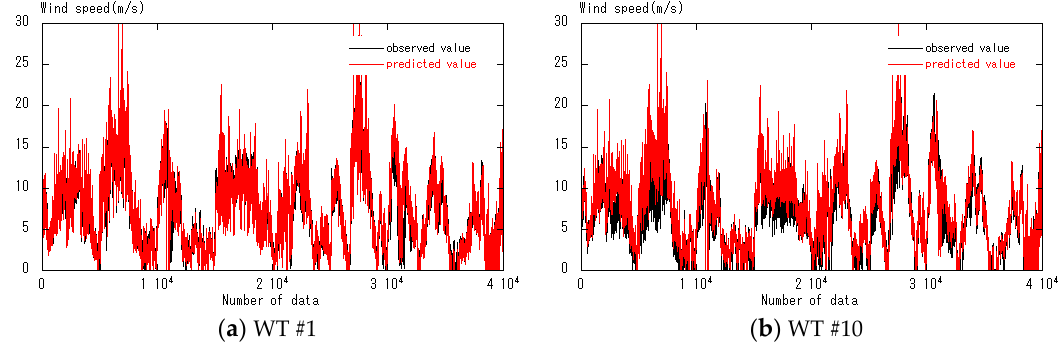
Figure 9. Time-series data of observed and predicted wind speed, reference point: WT #4.